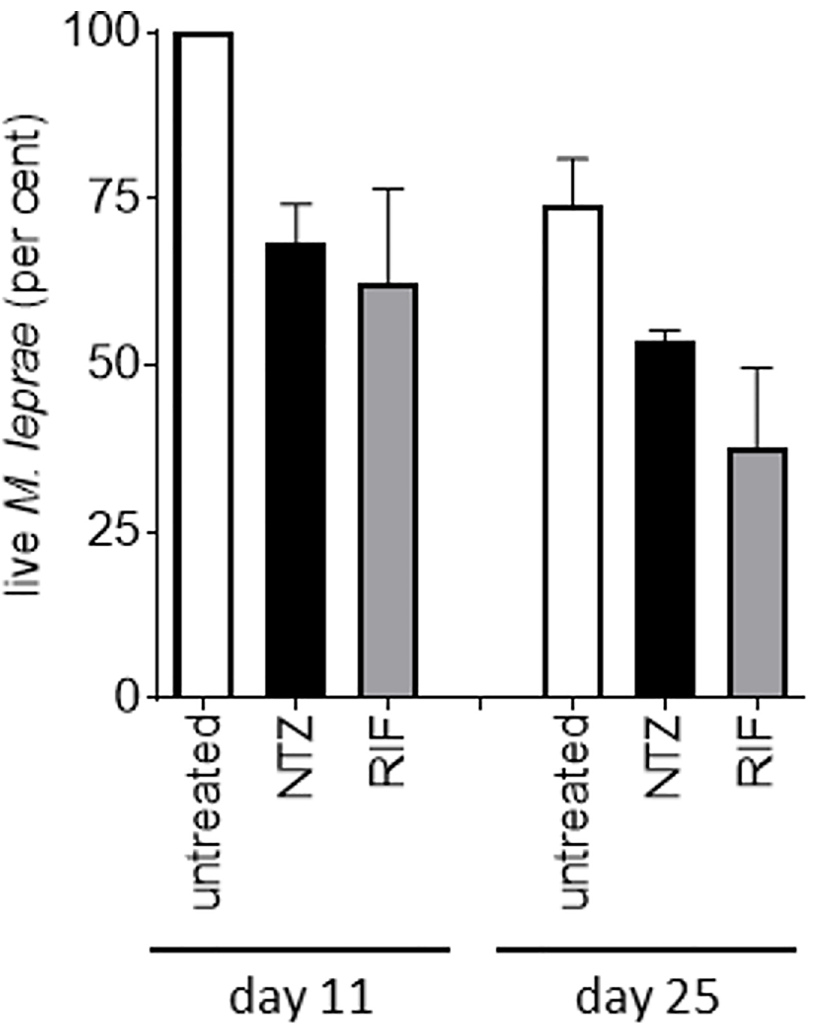
Fig 2. Bactericidal kinetics for RIF and NTZ against M . leprae in axenic medium. M . leprae was incubatedin medium plus 2 μ g/mL rifampicin(RIF) or 100 μ g/mL nitazoxanide (NTZ). Viablebacteria were determined after 11 and 25 days using live-dead staining (SYTO 9/propidiumiodide).Untreatedcontrol containedDMSO only. Results are shown as mean and standard deviationof 3 independentsamples.